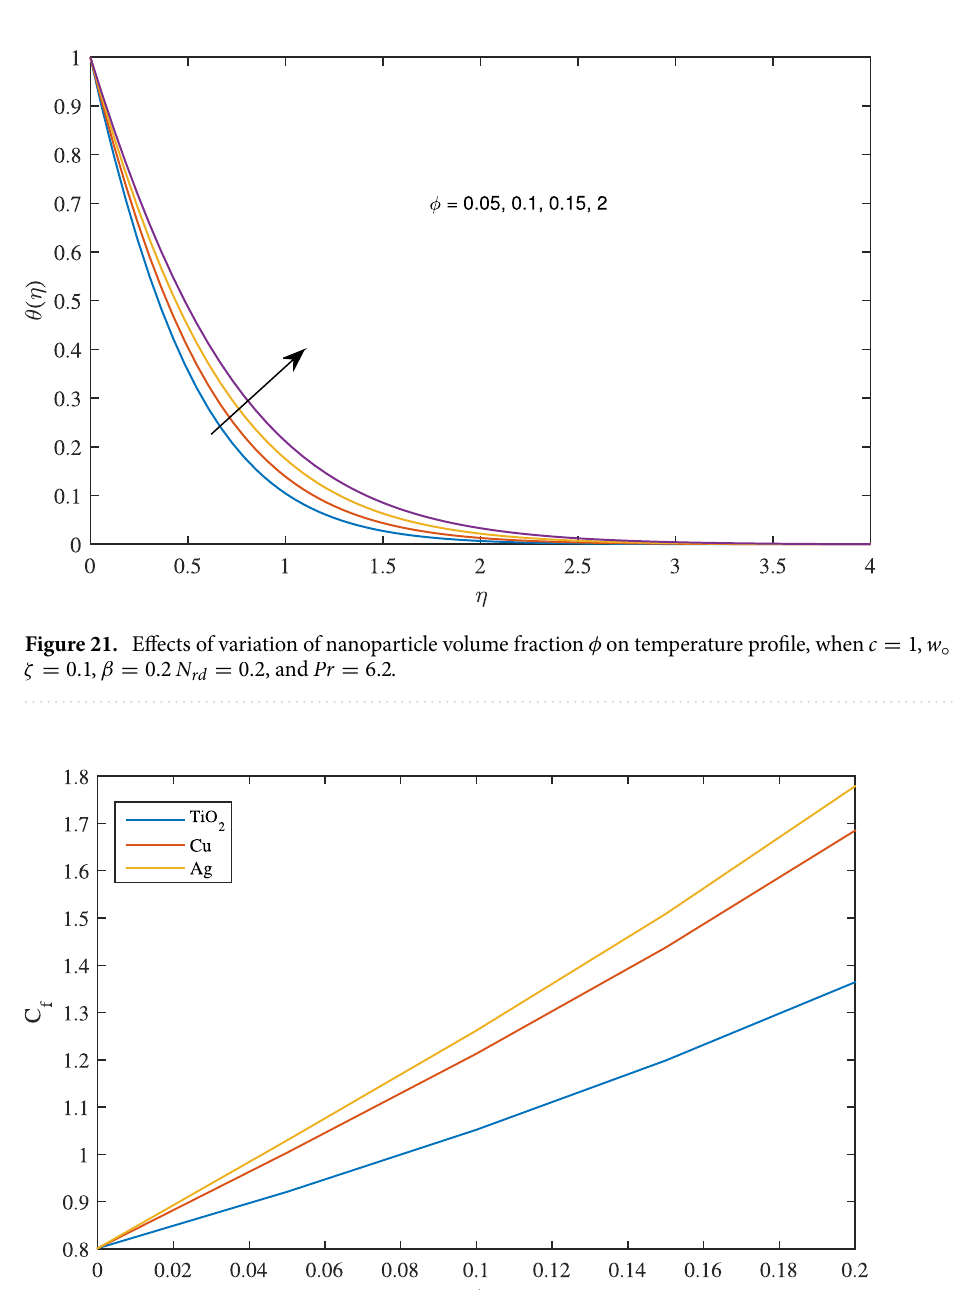
0.1 , w 0.1 0.1 , ζ = = ◦ =